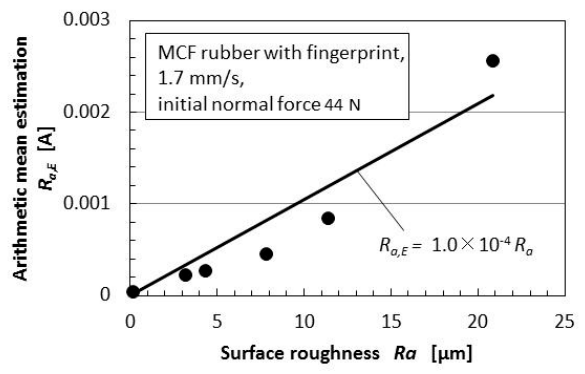
Figure A2. Relation between the parameter estimated of surface roughness of a body and the one of electric current curve measured by dry-type MCF rubber under rubbing speed and pressing force which is presented as “initial normal force” in the figure [27].